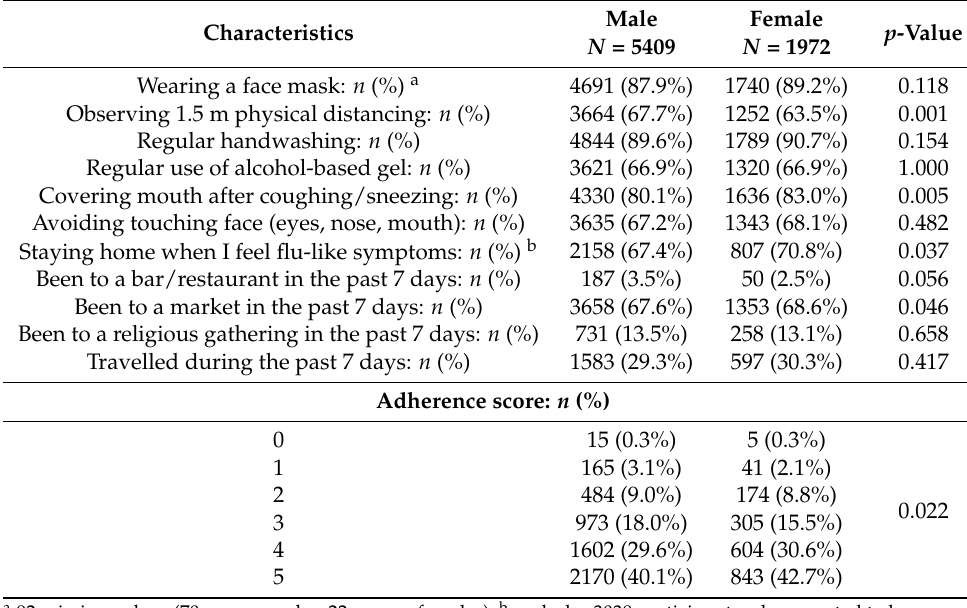
Table 2. Reported COVID-19 preventive behaviours and adherence scores among participants.